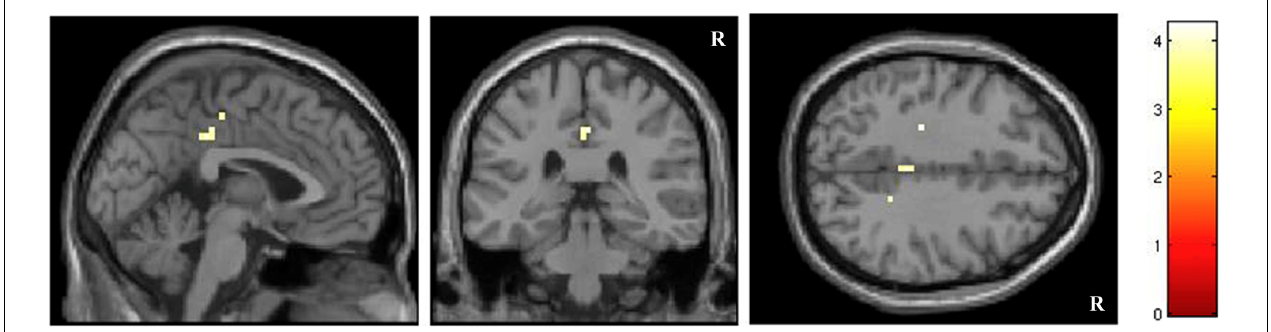
FIGURE 3 | Correlation voxel-wise analysis between anosognosia scores measured with CIRS and functional brain response for dementia-related words ( p < 0.001 uncorrected).